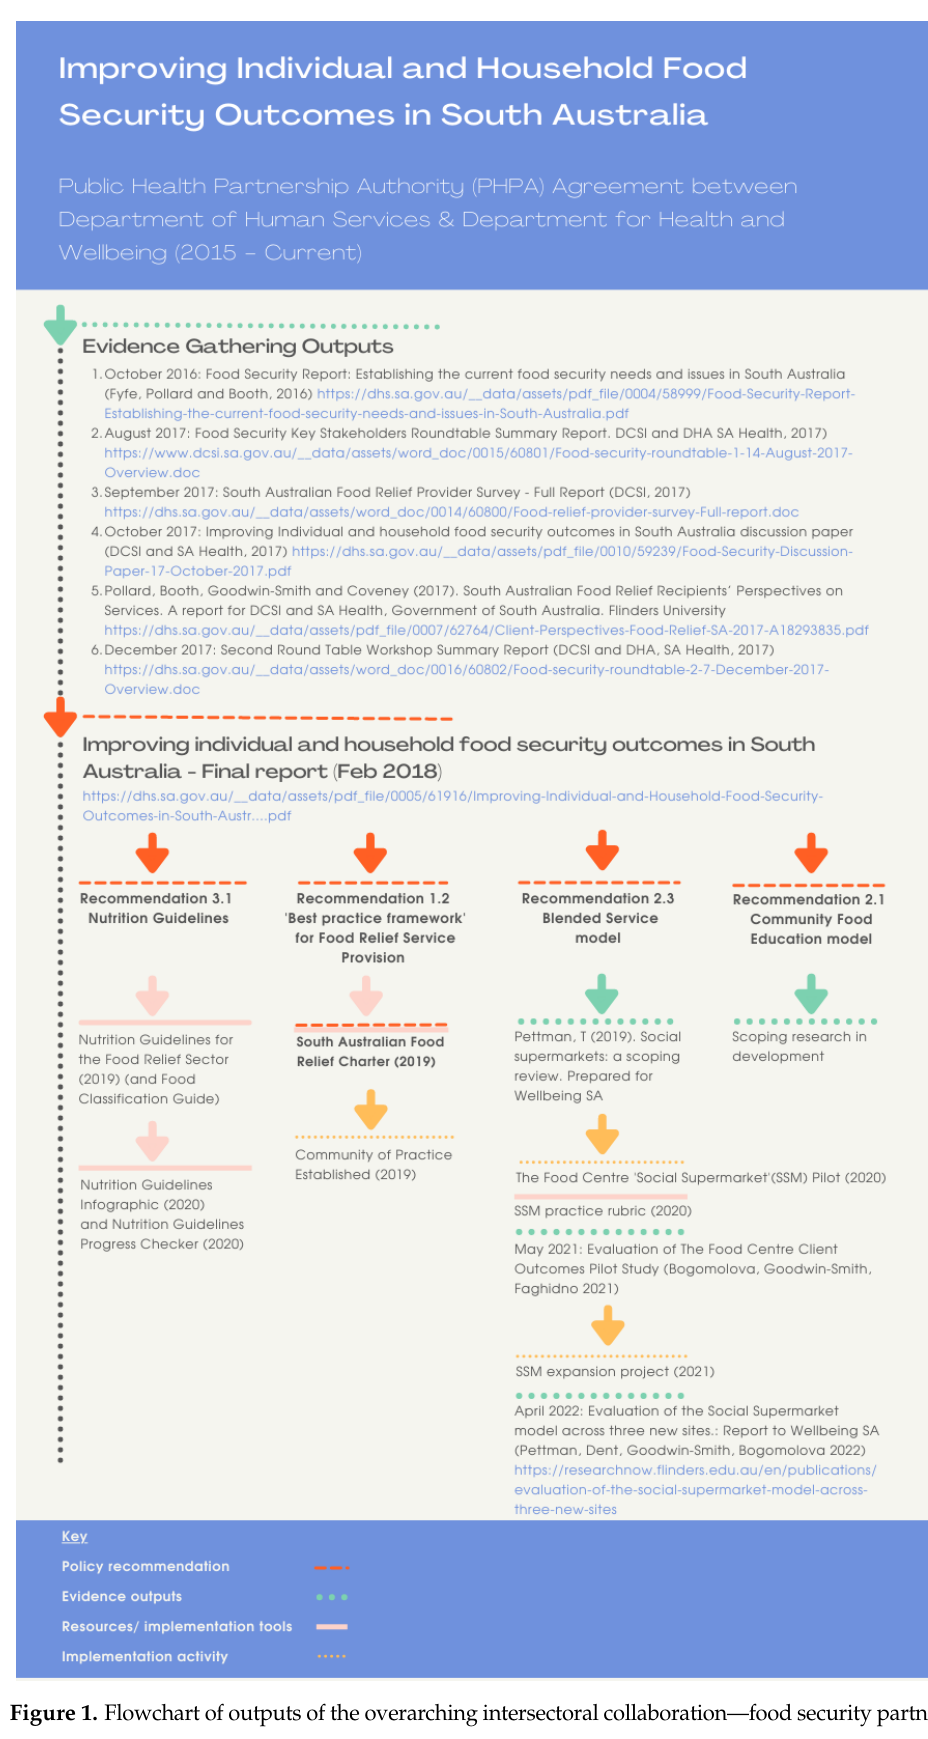
Figure 1. Flowchart of outputs of the overarching intersectoral collaboration—food security partnership.